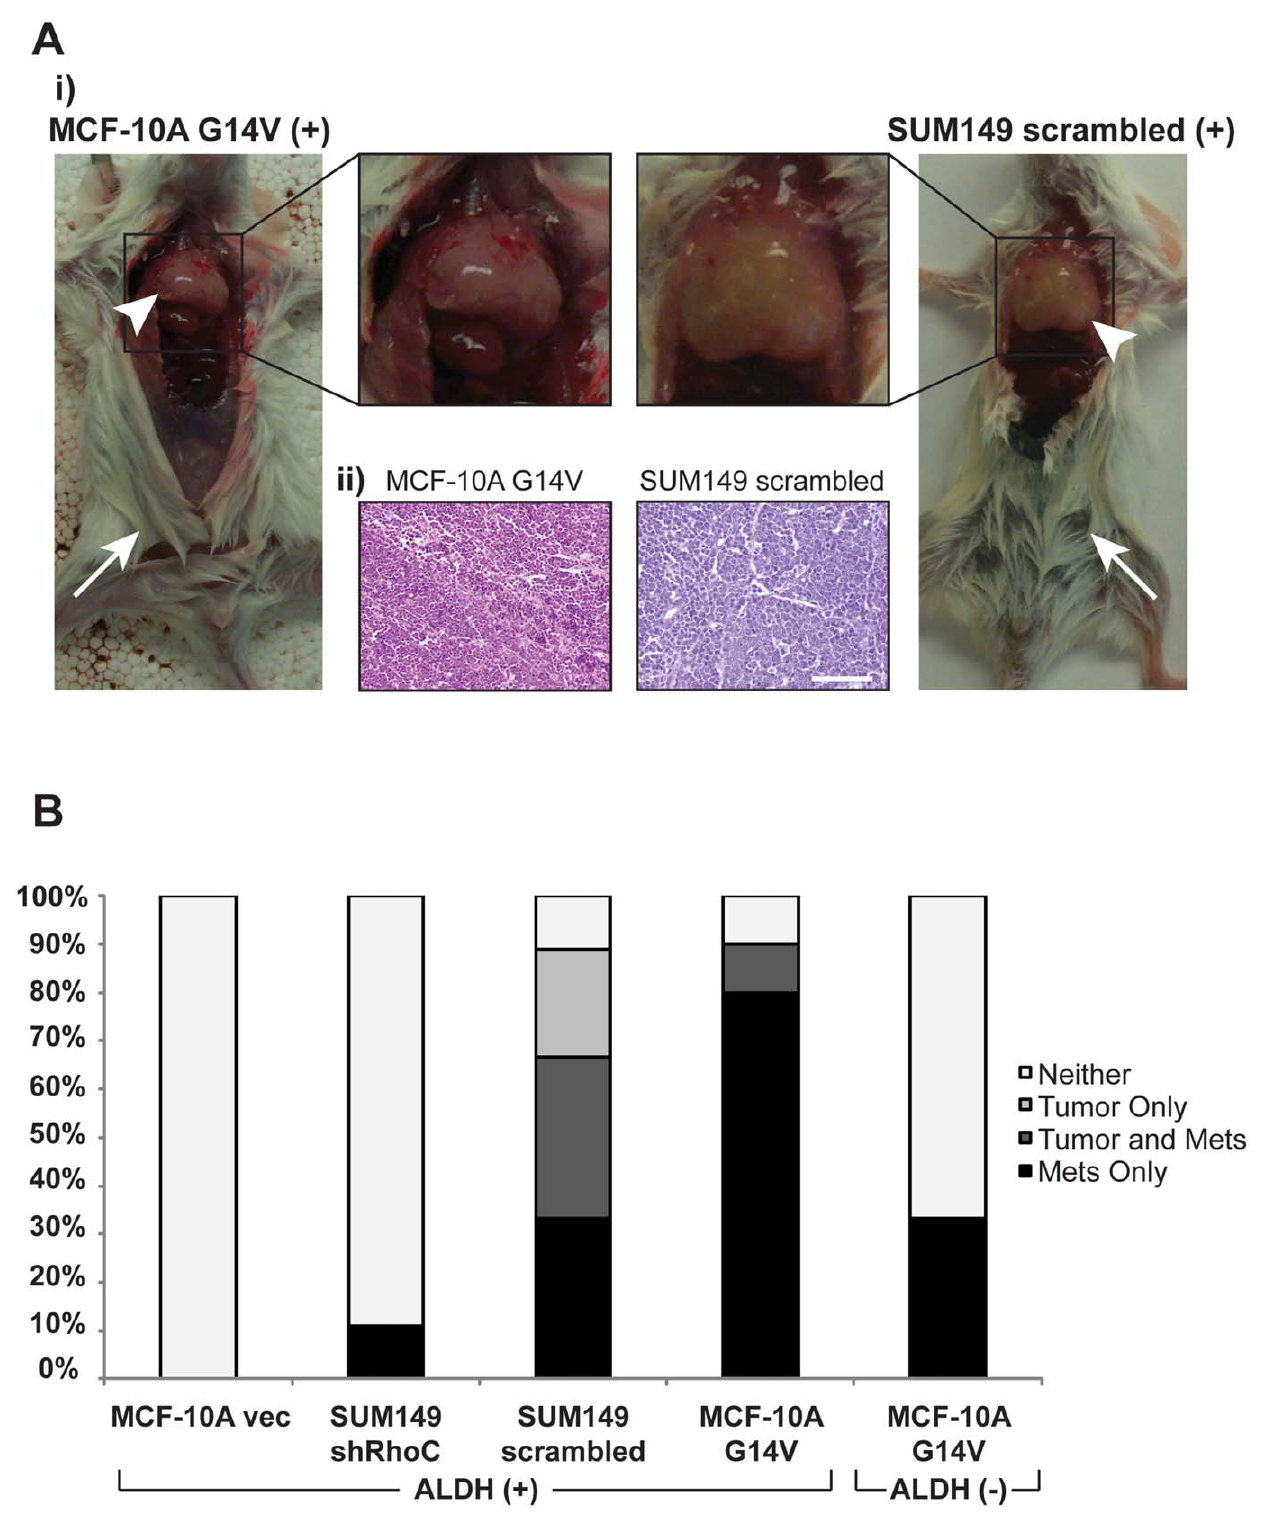
Figure 3. RhoC expression determines metastasis of SUM149 and MCF-10A ALDH ( + ) BCSCs. ( A ) NOD/SCID mice orthotopically xenografted with only 50 SUM149 or 5000 MCF-10A G14V cells form large lung metastases, often independent of primary tumor formation. i ) Arrows indicate injection sites lacking primary tumors, arrowheads denote lung metastases. ii ) H&E-staining shows that lung metastases from both MCF-10A G14V and SUM149 scrambled cells are poorly-differentiated invasive carcinomas (scale =50 m m) ( B ) Quantitative analysis of xenografted mice establishes RhoC as both necessary and sufficient for SUM149 and MCF-10A G14V ALDH ( + ) BCSC lung metastasis (also see Table 1). MCF-10A cells overexpressing RhoC G14V metastasize independent of primary tumor formation. Note that even ALDH ( 2 ) MCF-10A G14V, which have reduced but not completely eliminated constitutively active RhoC expression, do not form primary tumors but can still metastasize, albeit less frequently, than